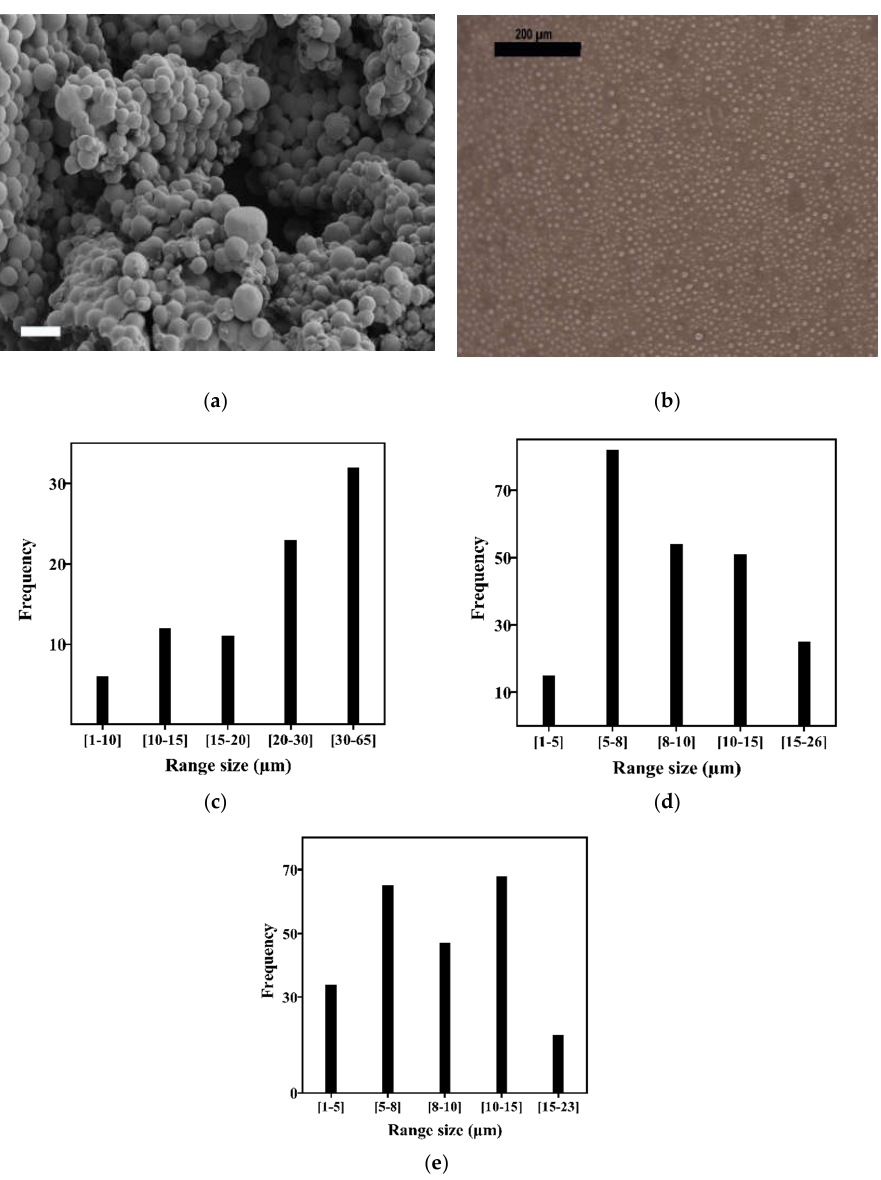
Figure 1. Physical microsphere characterization: ( a ) FESEM image of the microspheres (bar: 20 µm), ( b ) image of microgel dispersion in a P24 well, ( c ) size distribution at 750 rpm, ( d ) 1500 rpm, and ( e ) 2000 rpm.